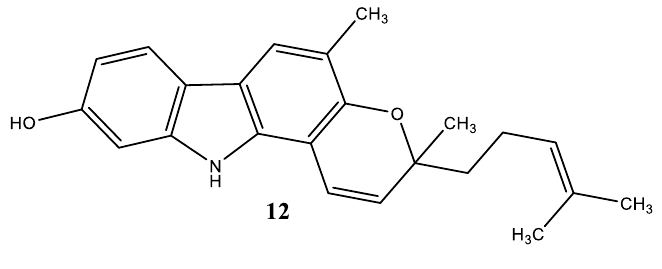
Figure 8. Structure of mahanine ( 12 ).